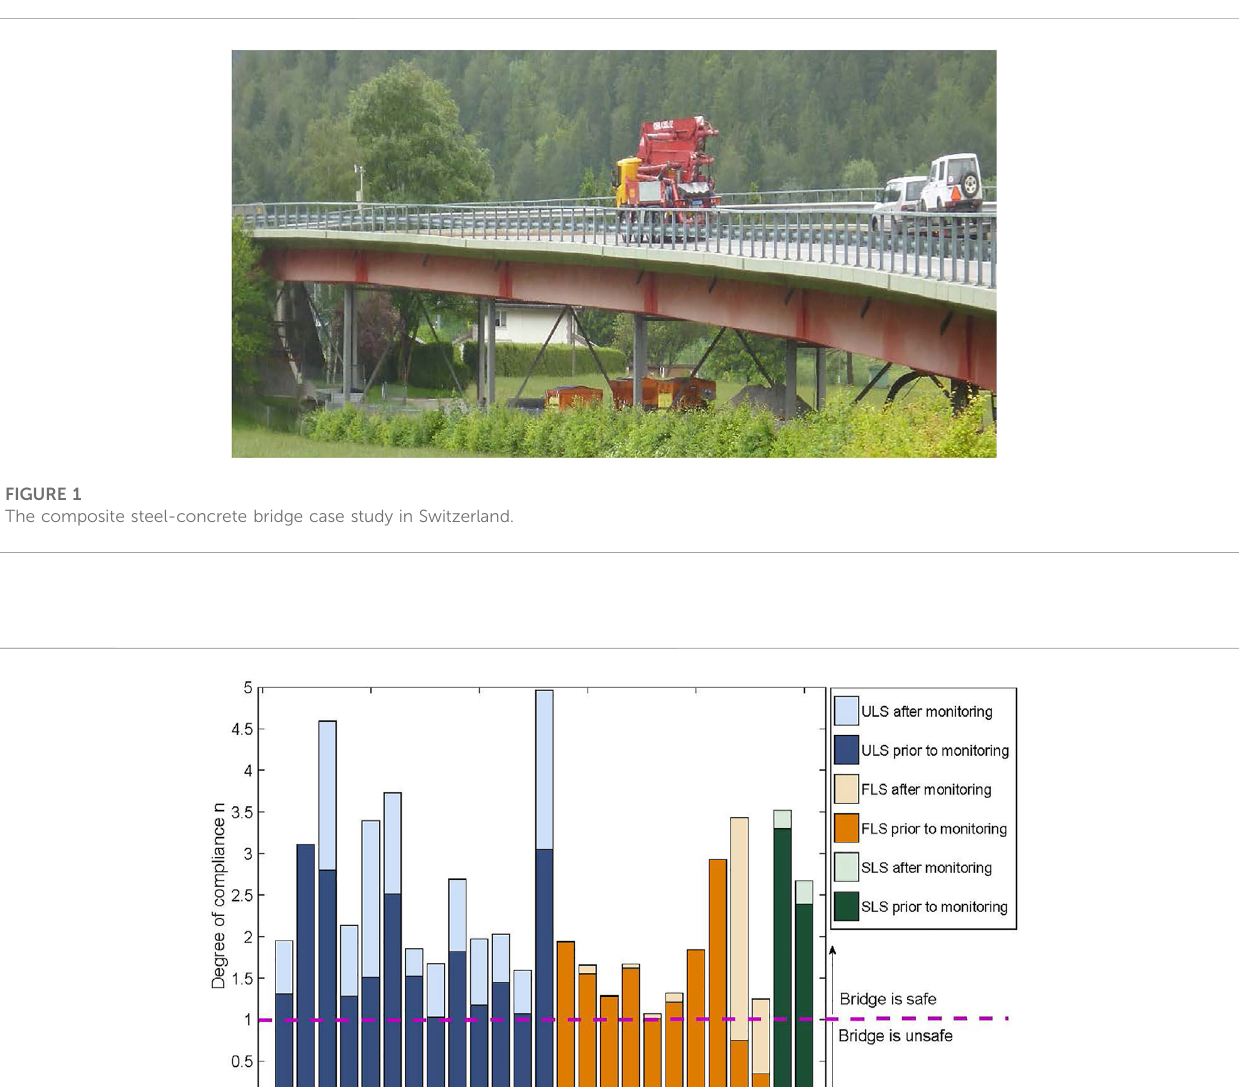
Frontiers in Built